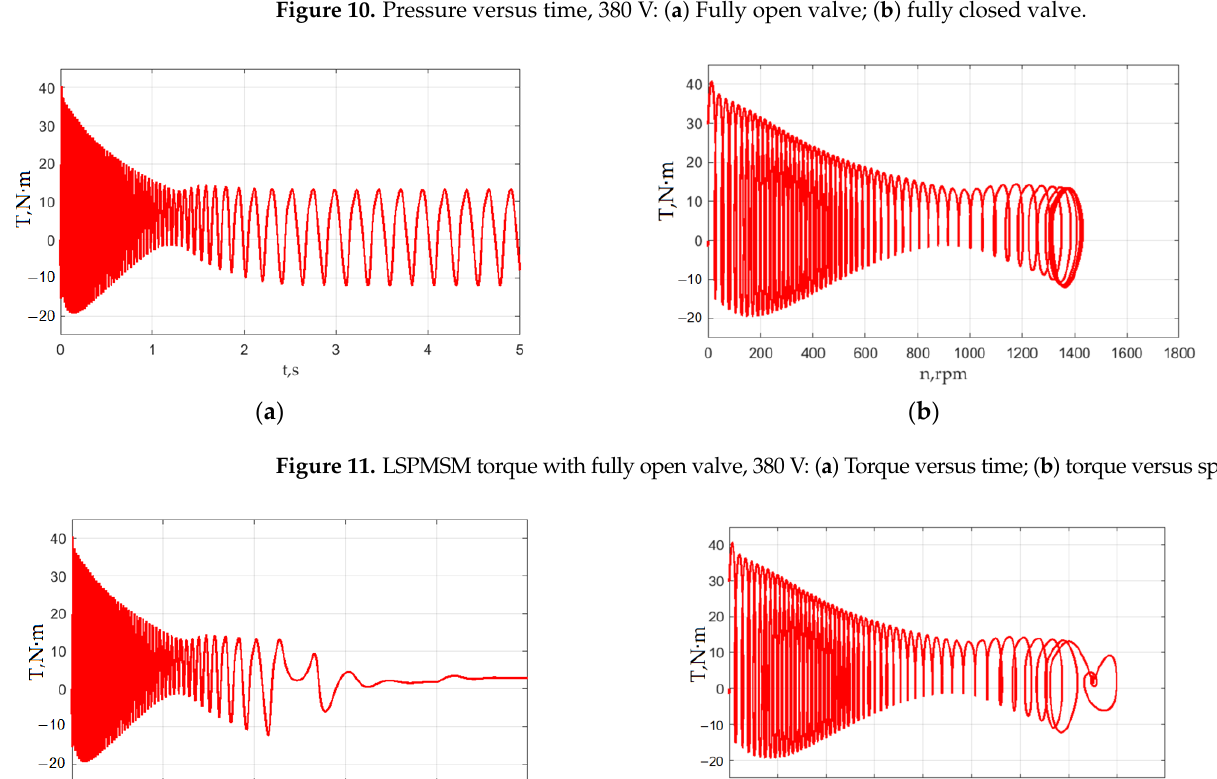
Figure 10. Pressure versus time, 380 V: ( a ) Fully open valve; ( b ) fully closed valve.